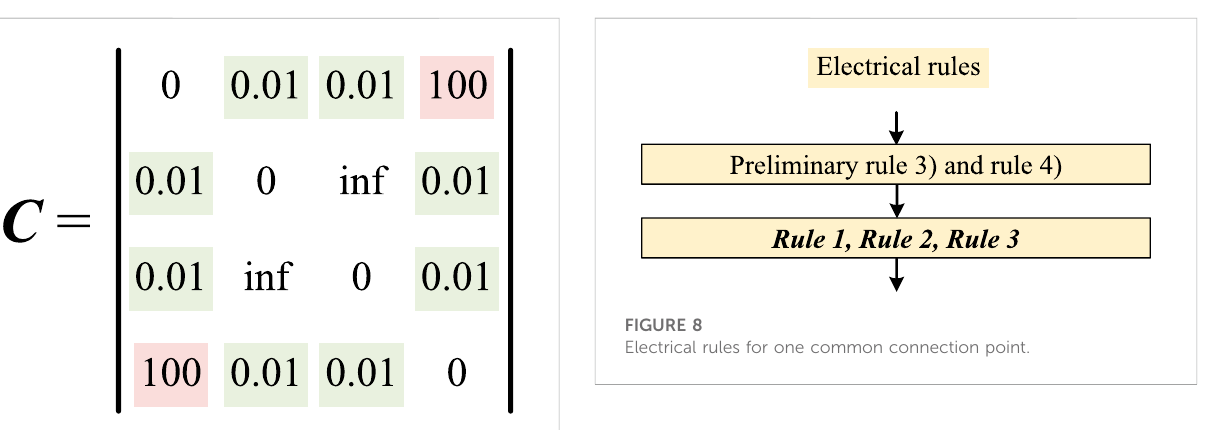
FIGURE 7 Adjacency matrix example.